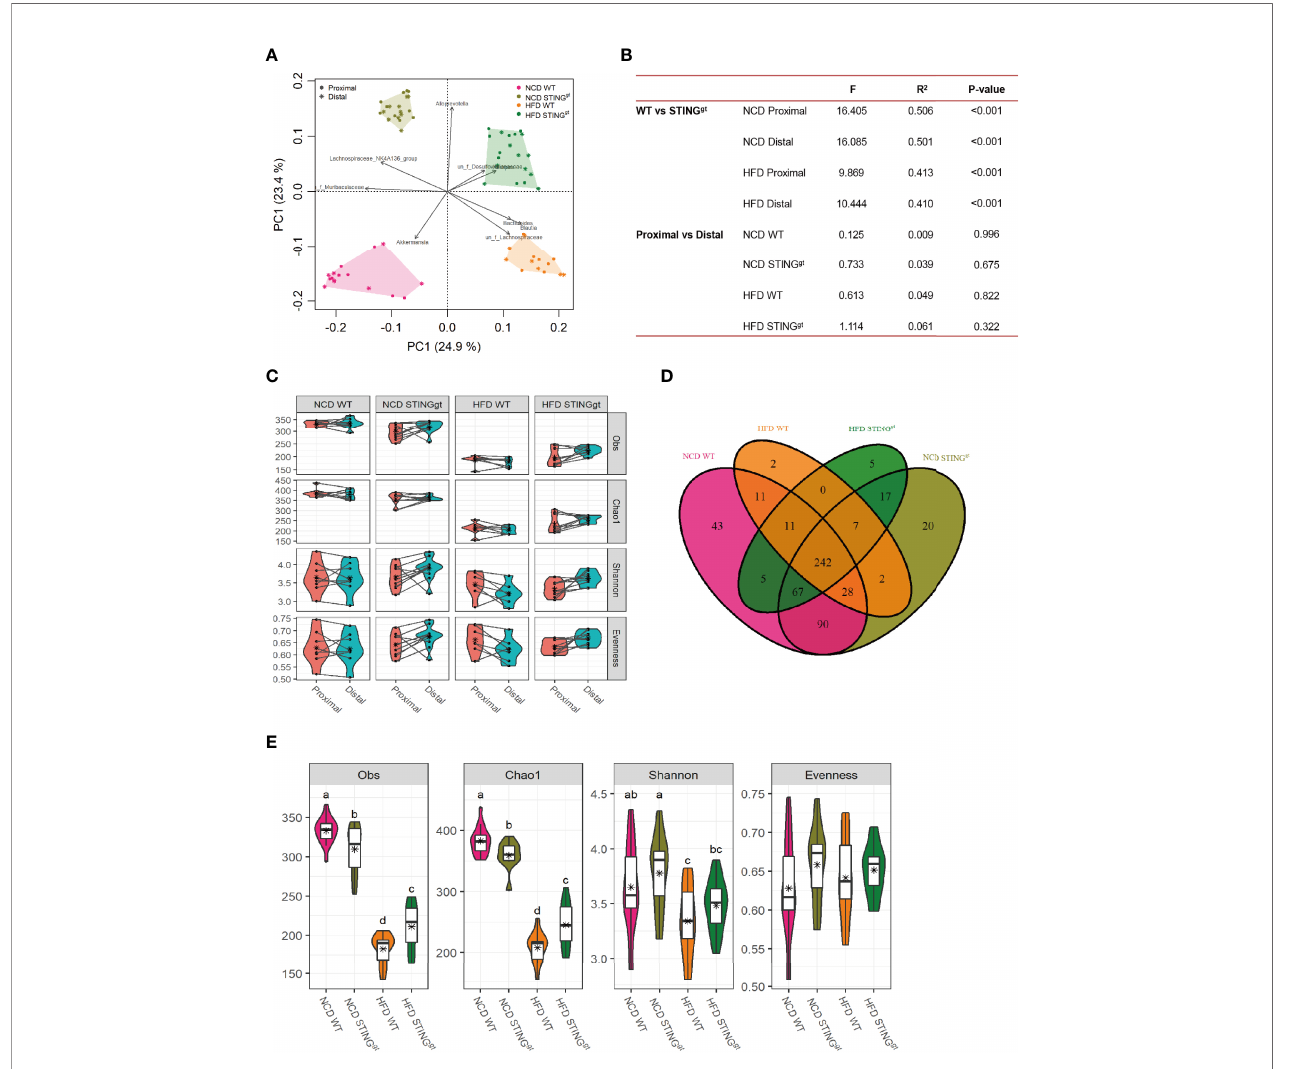
FIGURE 4 | The effect of STING on biodiversity of gut microbiota. (A) OTU Venn analysis of samples in different groups. (B) The principal coordinate analysis (PCoA) of all samples at the OTU level; the points represent samples, and shapes represent the different group. (C) The changes of a -diversity (including Obs, Chao1, Shannon, and Evenness) in each group. (D) Comparison of microbiota a -diversity between the proximal and distal colons of mice. (E) Statistical analysis of differences in gut microbiota among different diets, genotypes, and colonic segments, with letters indicating the grouping and stars representing the mean values. Obs, observed